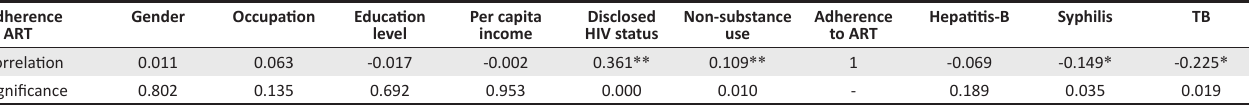
TABLE 4: Correlation coefficient of > 95 % antiretroviral treatment adherence. Adherence to ART